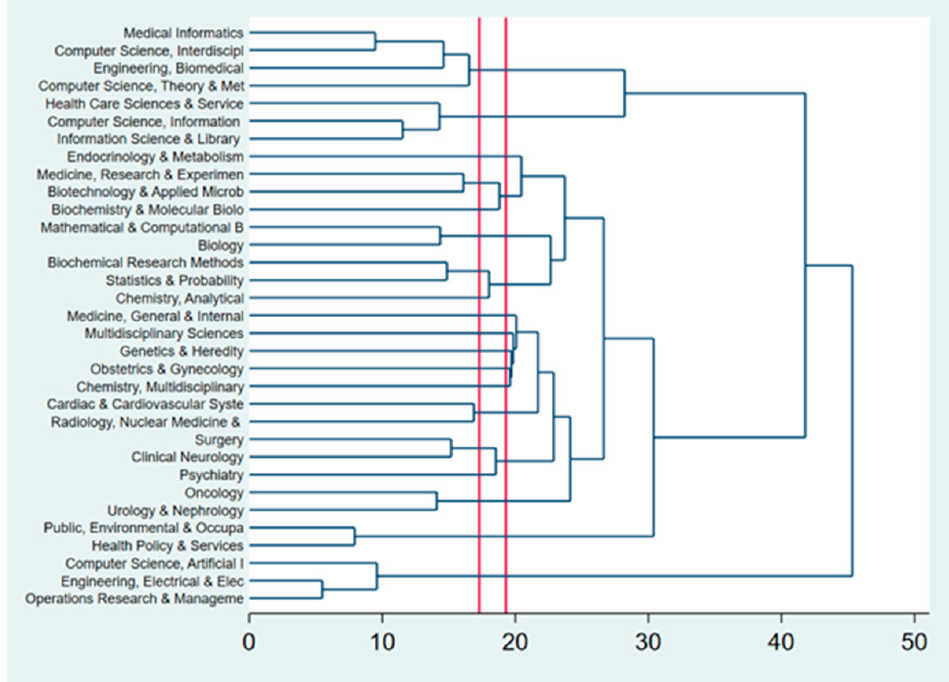
Figure 4. The clustering of research disciplines (WOS classification) used in Artificial Intelligence and Diabetes.